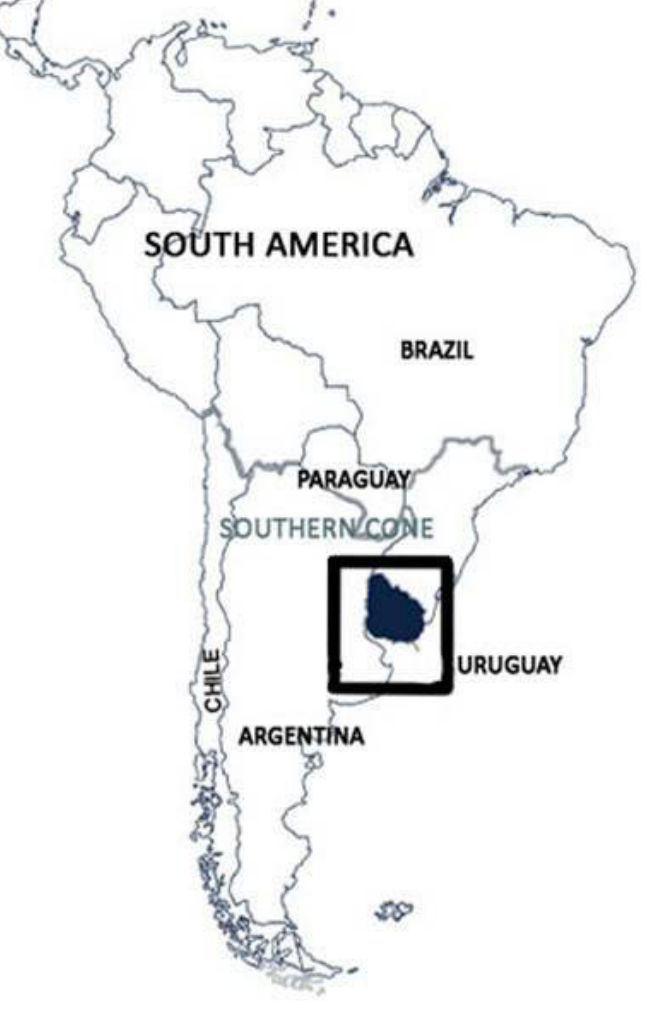
Figure 1. The location of the study area within South